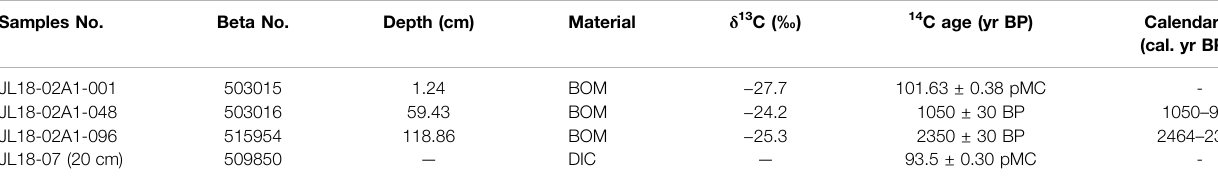
TABLE 1 | Results of AMC 14 C dating of core JL18-02-A. Samples No.